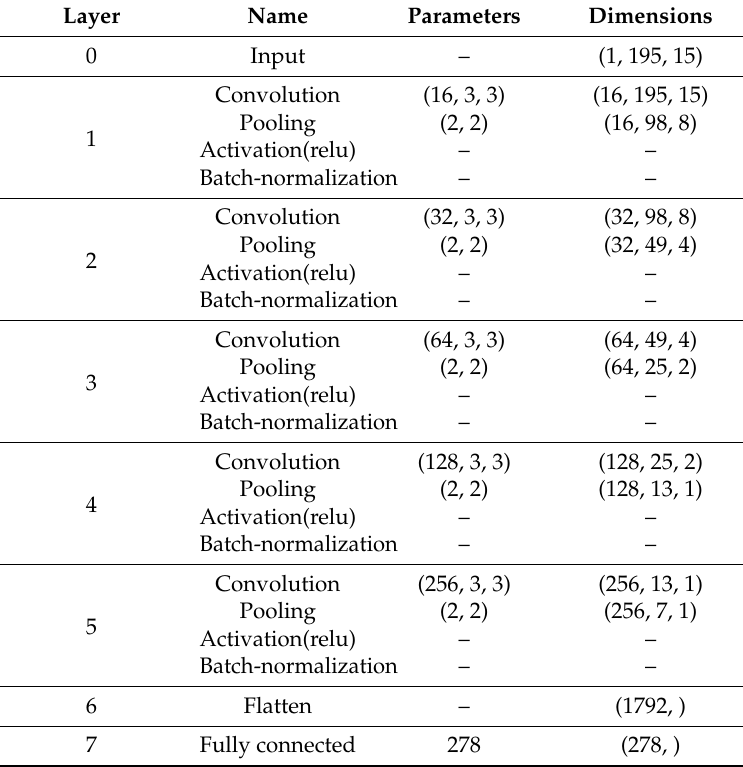
Table A2. Hyperparameters of the CNN when α = 0.70